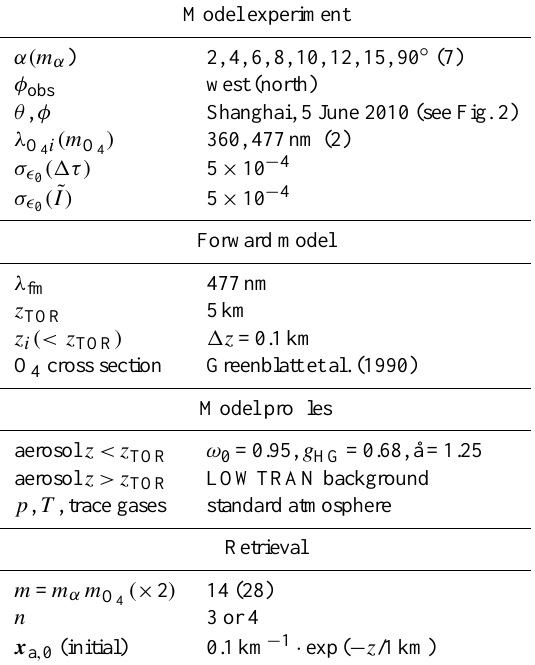
Table 1. Settings for model experiments and retrieval unless stated otherwise in the text. The model errors σ (cid:15) cal depths and the relative intensities are adopted from Frieß et al. (2006) (for the wavelength